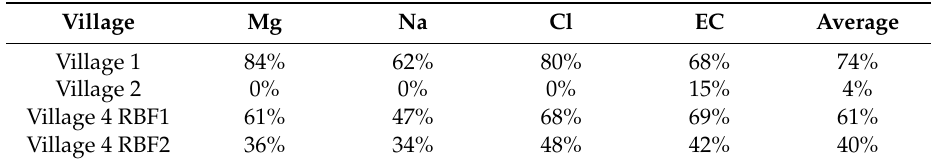
Table 4. Contribution (%) of river water to RBF well water based on mixing ratios from ion, dissolved silica, and electric conductivity (EC) measurements. Note: Both RBF wells at Village 1 were lumped together because of their